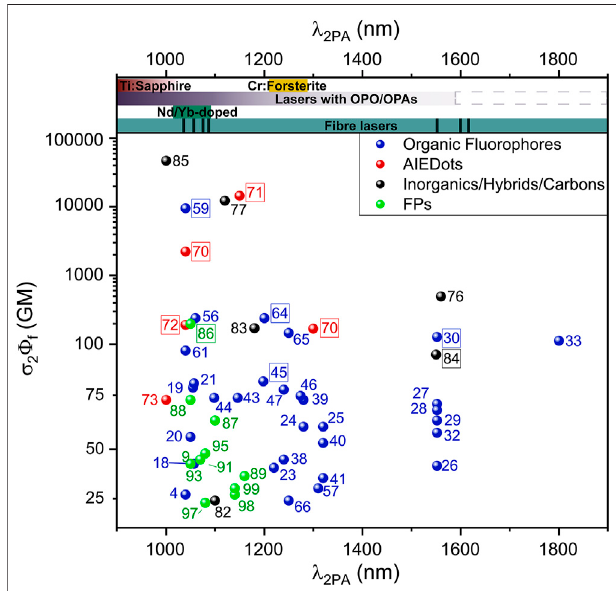
FIGURE 9 | Plot of the 2P brightness and corresponding NIR-II wavelengths of the contrast agents presented in this review ( σ 2 Φ f > 24 GM). The 2P contrast agents used in vivo are represented with a framed number. For clarity, a linear scale for brightnesses between 0 and 100 GM, and a logarithmicscaleabove100 GM.Thetypicalrangeofwavelengthscoveredby common SWIR lasers is shown for reference (power attenuation is represented by the fading colour; note that OPOs and OPAs can extend past 2000